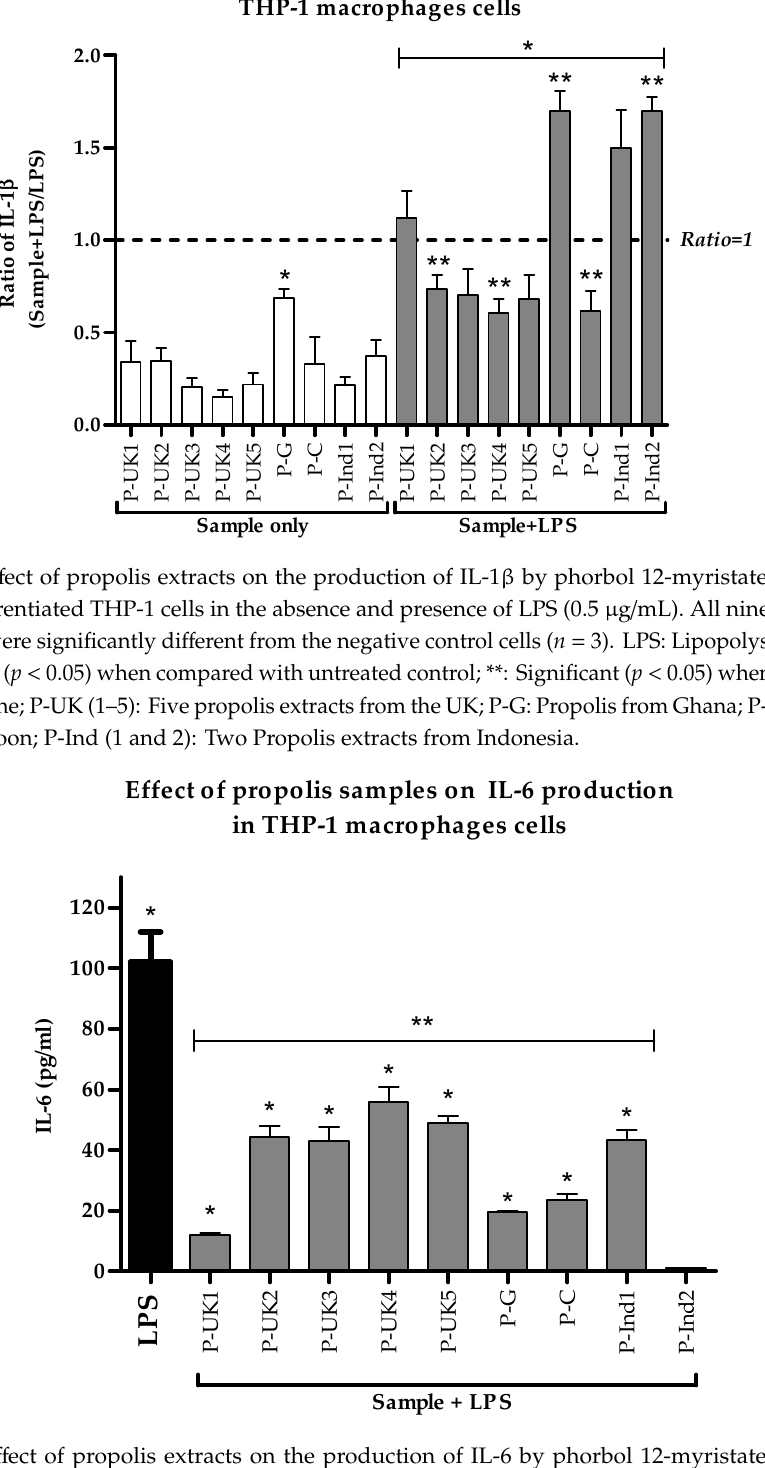
Figure 4. Effect of propolis extracts on the production of IL-6 by phorbol 12-myristate 13-acetate (PMA)-differentiated THP-1 cells in the absence and presence of LPS (0.5 µg/mL). All eight combined treatments apart from the P-Ind2 extract were significantly different from the negative and positive control ( n = 3). LPS: Lipopolysaccharides; *: Significant ( p < 0.05) when compared with untreated control; **: Significant ( p < 0.05) when compared with LPS; P-UK (1–5): Five propolis extracts from the UK; P-G: Propolis from Ghana; P-C: Propolis from Cameroon; P-Ind (1 and 2): Two Propolis extracts from Indonesia.